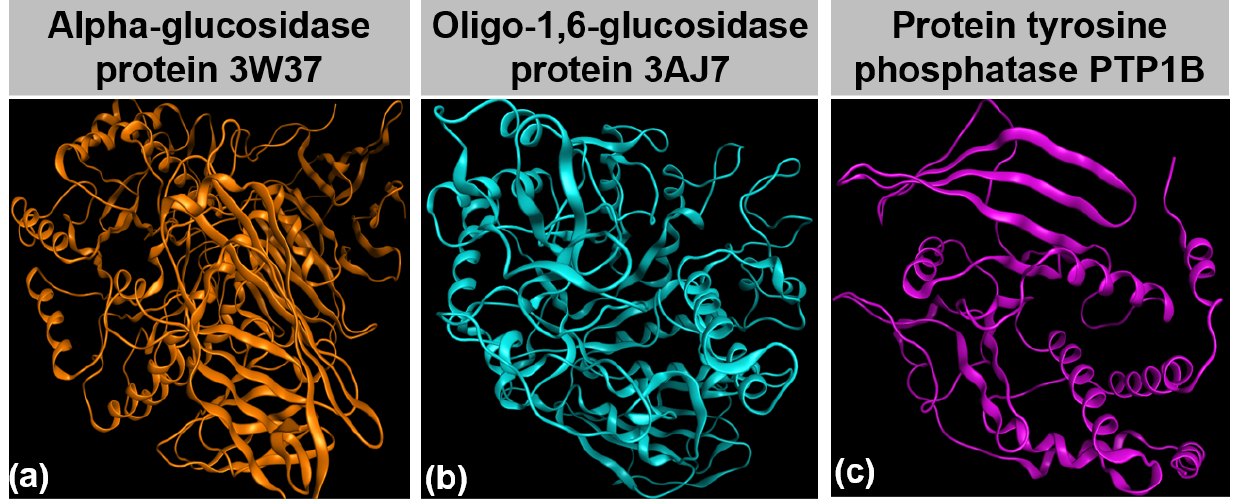
Figure 1. ( a ) α -glucosidase protein 3W37; ( b ) Oligo-1,6-glucosidase protein 3AJ7; ( c ) Protein tyrosine phosphatase 1B. Tetradium ruticarpum (A. Juss.) T.G. Hartley (Ngô thù, Xà l ạ p in Vietnamese) is a